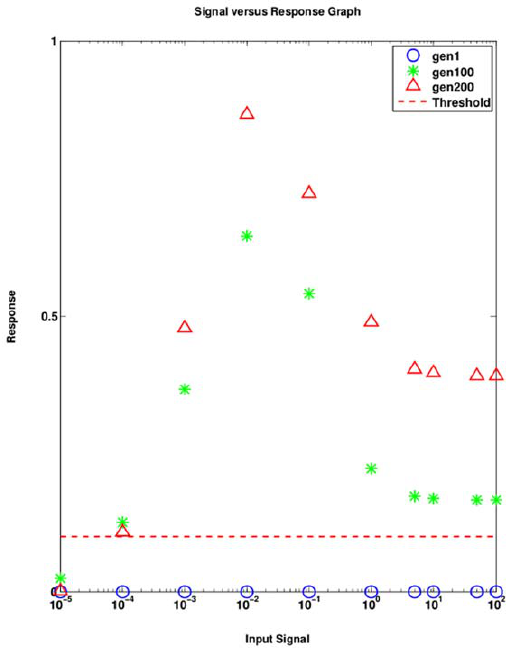
Figure 6. Dose-response relationship of the evolved SNs for the strong interaction regime. The graph shows the input signal versus the maximum response of the output node of the best network in the respective generations 1 , 100 , and 200 .